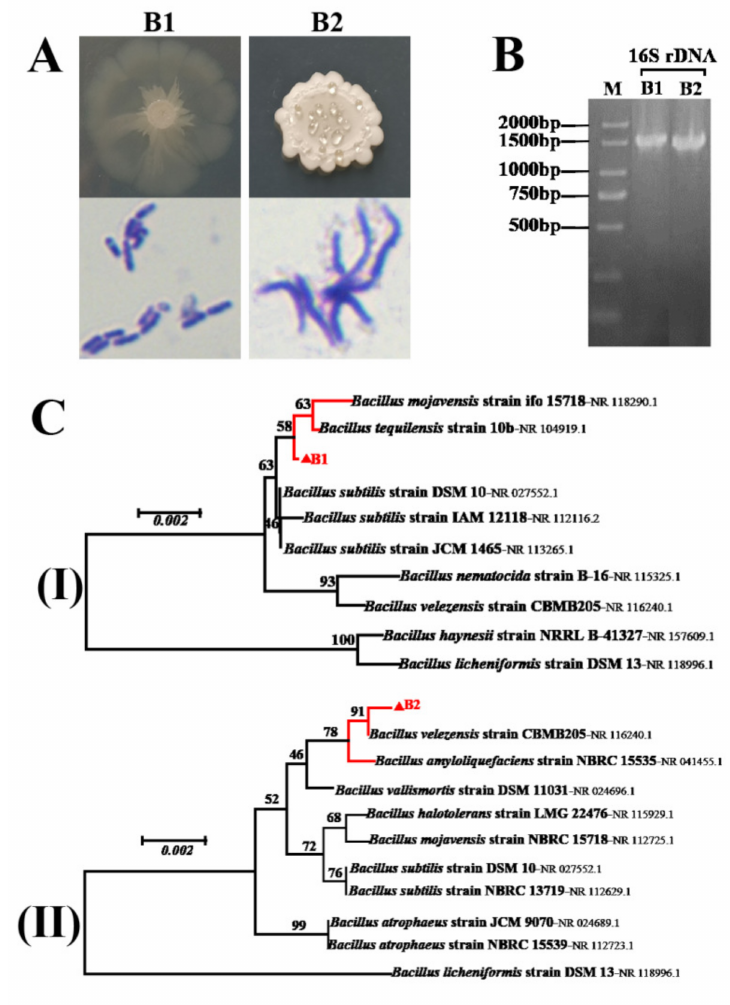
Figure 2. Identification of bacterial isolates B1 and B2 from morphologies and genetics. ( A ) Morphol- ogy and Gram staining of B1 and B2. Colony pictures were taken at four days post-inoculation by applying 5 µ L of a bacterial suspension on the center of a LB plate (diameter 9 cm). ( C ) Phylogenetic trees were constructed by the neighbor-joining method based on 16S rDNA gene sequences ( B ), respectively showing the phylogenetic relationships of strain B1 (I) and B2 (II) and related species; numbers on branches are the bootstrap values that were based on 1050 replicates, and the scale bar indicates 0.002 substitutions per nucleotide